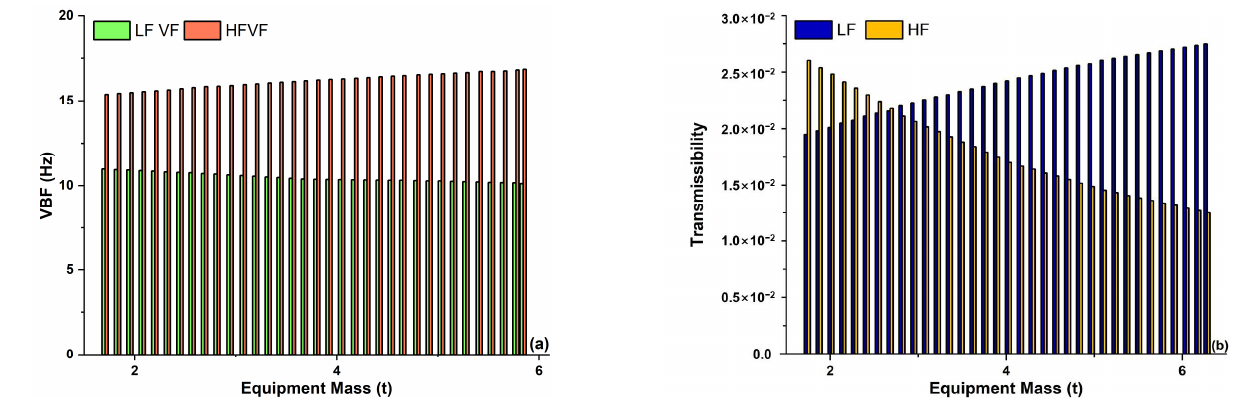
Figure 9. Effect of equipment mass on ( a ) VBF and ( b ) transmissibility for constant suspended equipment frequency.